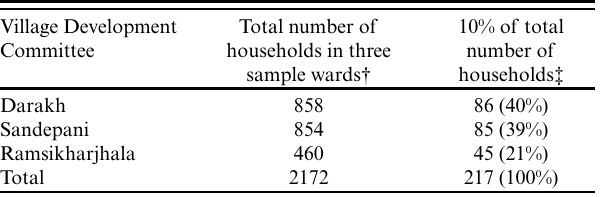
Table 1. List of Village Development Committees sampled and corresponding sample